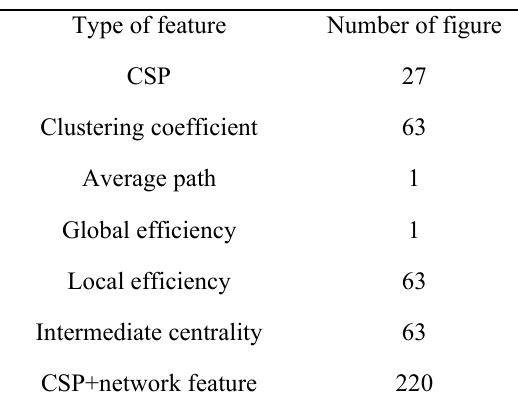
Table 2. The p values of different features for tristimania group and control group under different Table 3. Number of features used for tristimania